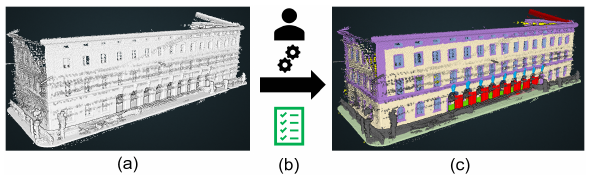
Figure 1. TUM-FAC¸ADE as a blueprint for enriching existing point cloud benchmarks: a) raw dataset, b) potential assessment, c) extended benchmark by fac¸ade